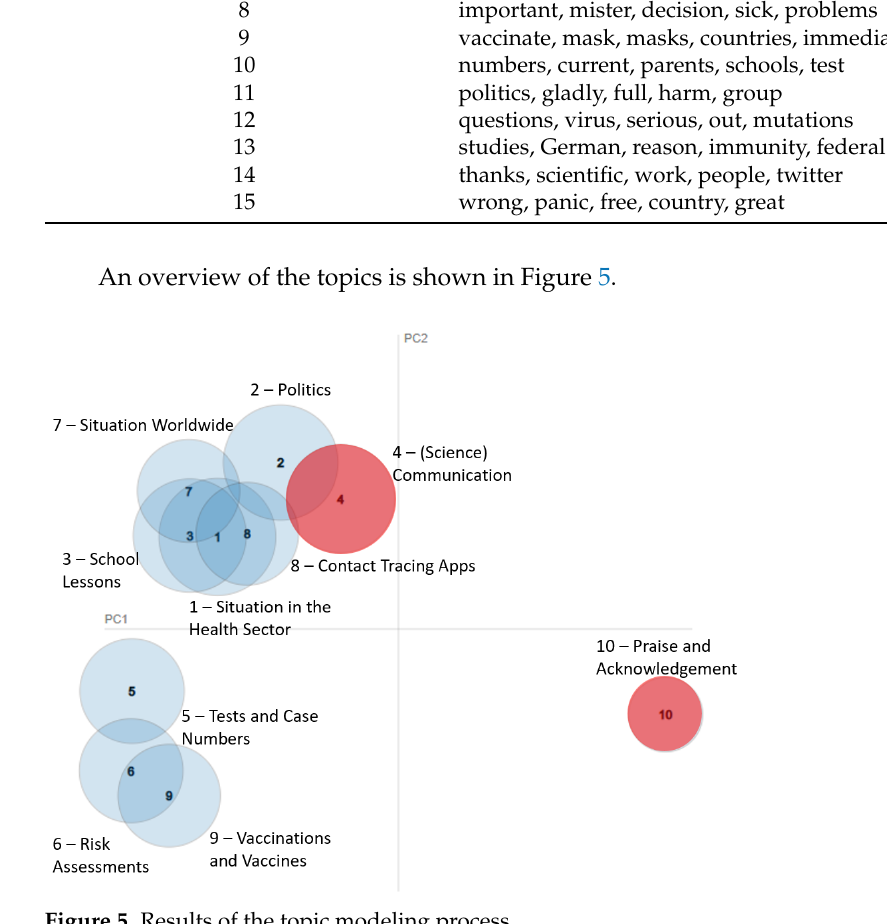
Figure 5. Results of the topic modeling